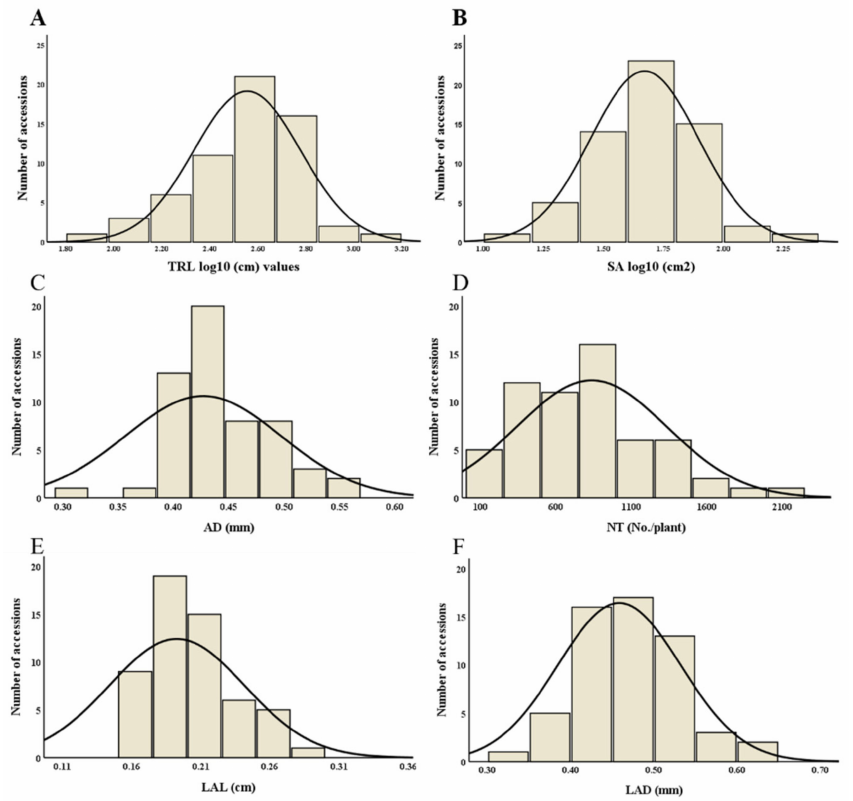
Figure 1. Histogram of normal distribution curves for root morphological traits. In the figure, each abbreviation indicates ( A ) total root length (TRL), ( B ) surface area (SA), ( C ) average diameter (AD), ( D ) number of tips (NT), ( E ) link average length (LAL), and ( F ) link average diameter